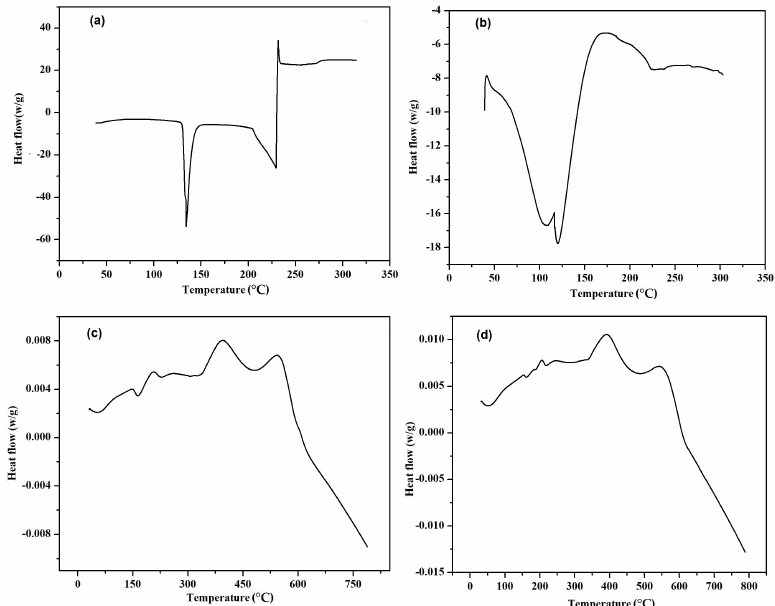
Figure 5. DSC of VRC ( a ), HP β CD ( b ), Blank ( c ), and loaded ( d ) HP β CD based polymeric nanobeads.